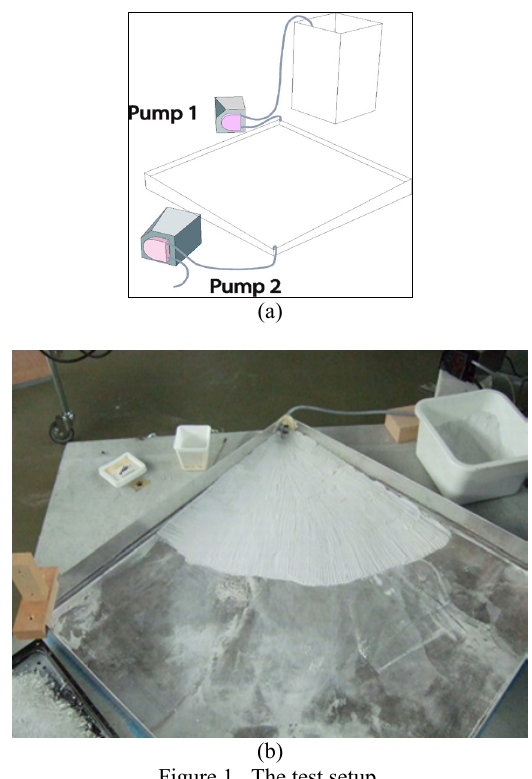
Figure 1. The test setup.